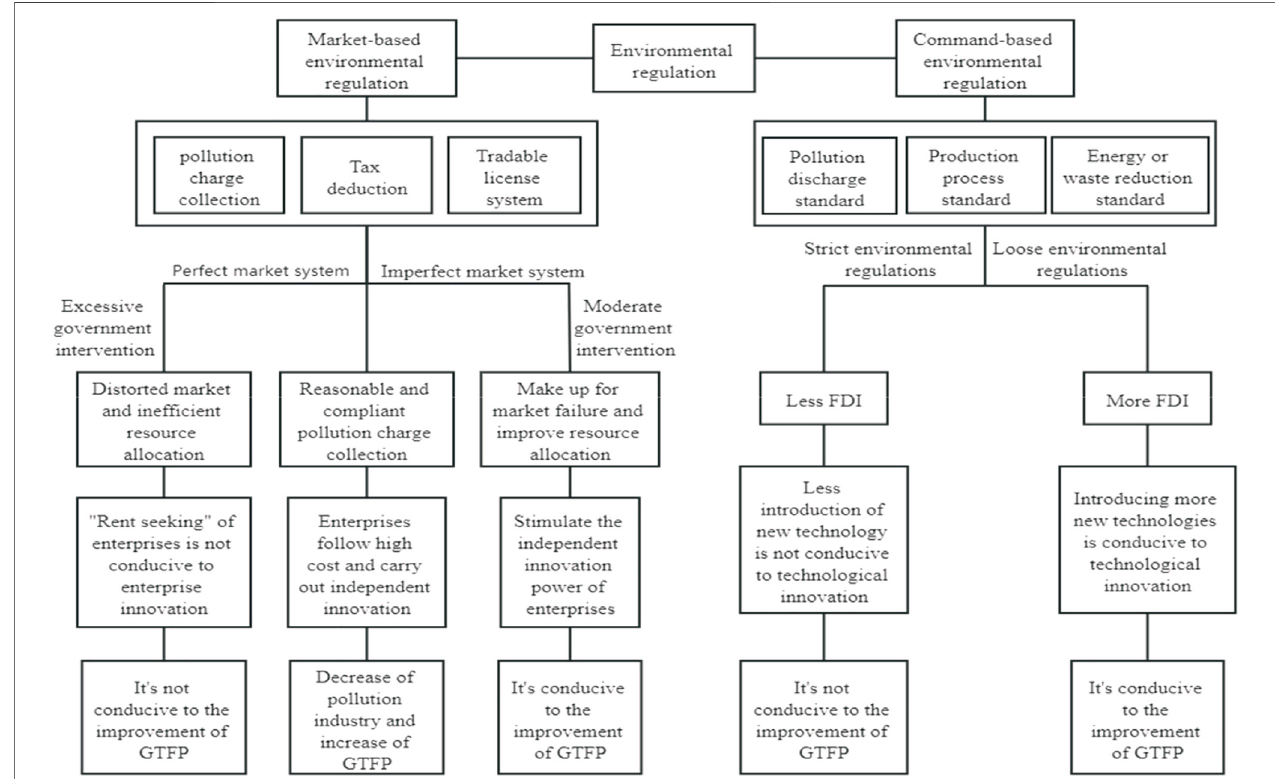
FIGURE 1 | The policy effect of two types of environmental regulations.